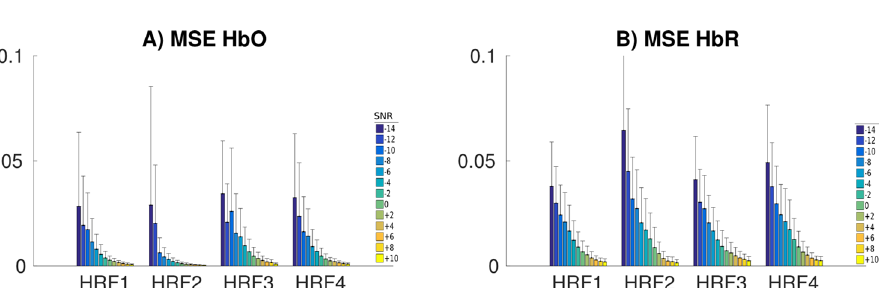
Figure 6. Distributions of MSE scores as a function of the SNR level for different HRF models. We show only the scores for SNRs ranging from − 14 dB (poor estimation below − 14 dB) to + 10 dB by steps of + 2